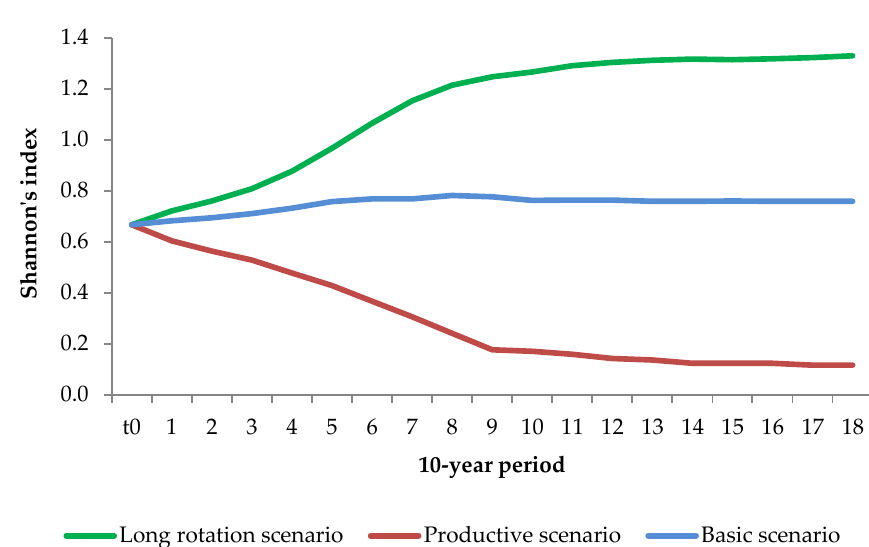
Figure 6. Mean Shannon’s index illustrating the average species diversity of stands in the studied management scenarios.